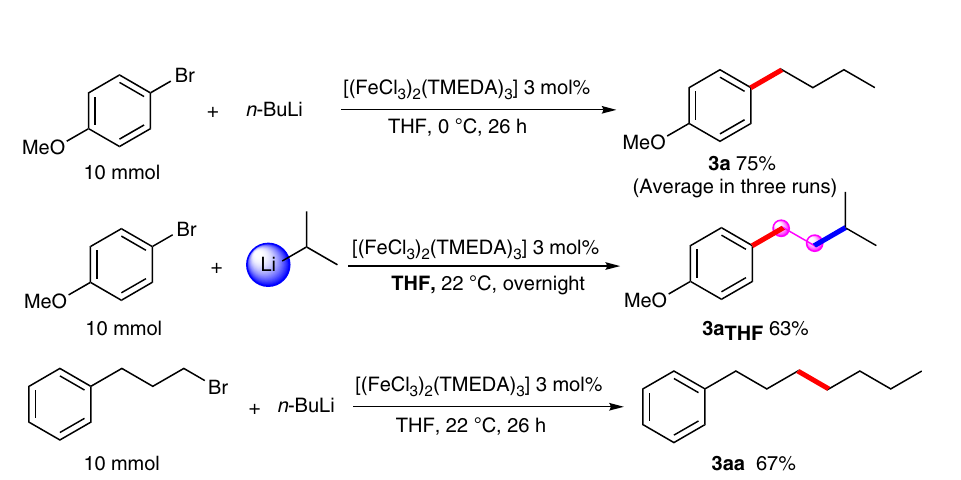
Figure 5 | Gram scale reactions. Three model substrates were selected to scale up to 10mmol scale and the corresponding target products were isolated in satisfied